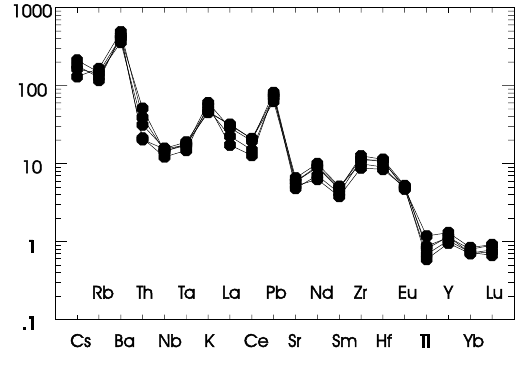
Fig. 8 – Spidergram of compatible and incompatible ele- ments of charnoenderbites from the outer domain. N-MORB- normalization after Sun and McDonough (1989). Explanation in text.